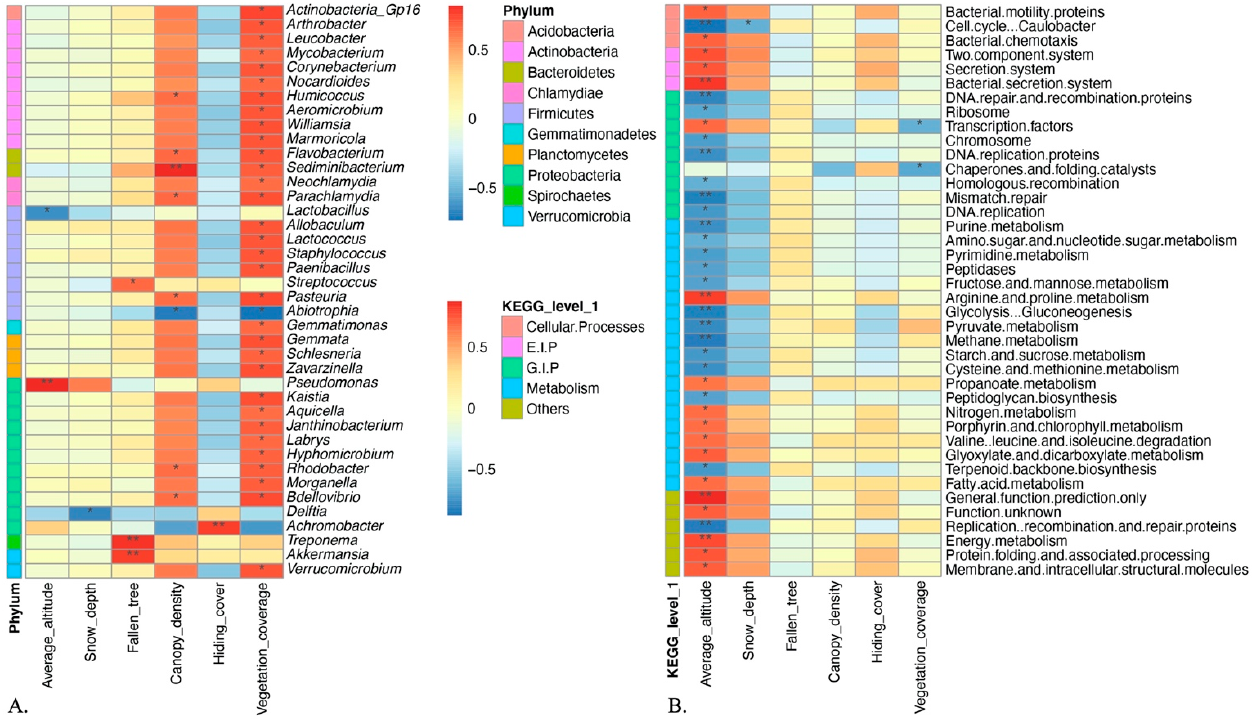
Figure 3. ( A ) Correlation analysis heatmap of bacterial genera and environmental factors. ( B ) Correlation analysis heatmap of pathways and environmental factors. Color changes from blue to red represents the correlation coefficient changes from − 1 to 1. Statistically significant ( p < 0.05 or p < 0.01) correlation between phyla and environmental factors are shown as single (*) or double asterisks (**), respectively. E.I.P = Environmental Information Processing, G.I.P = Genetic Information Processing.